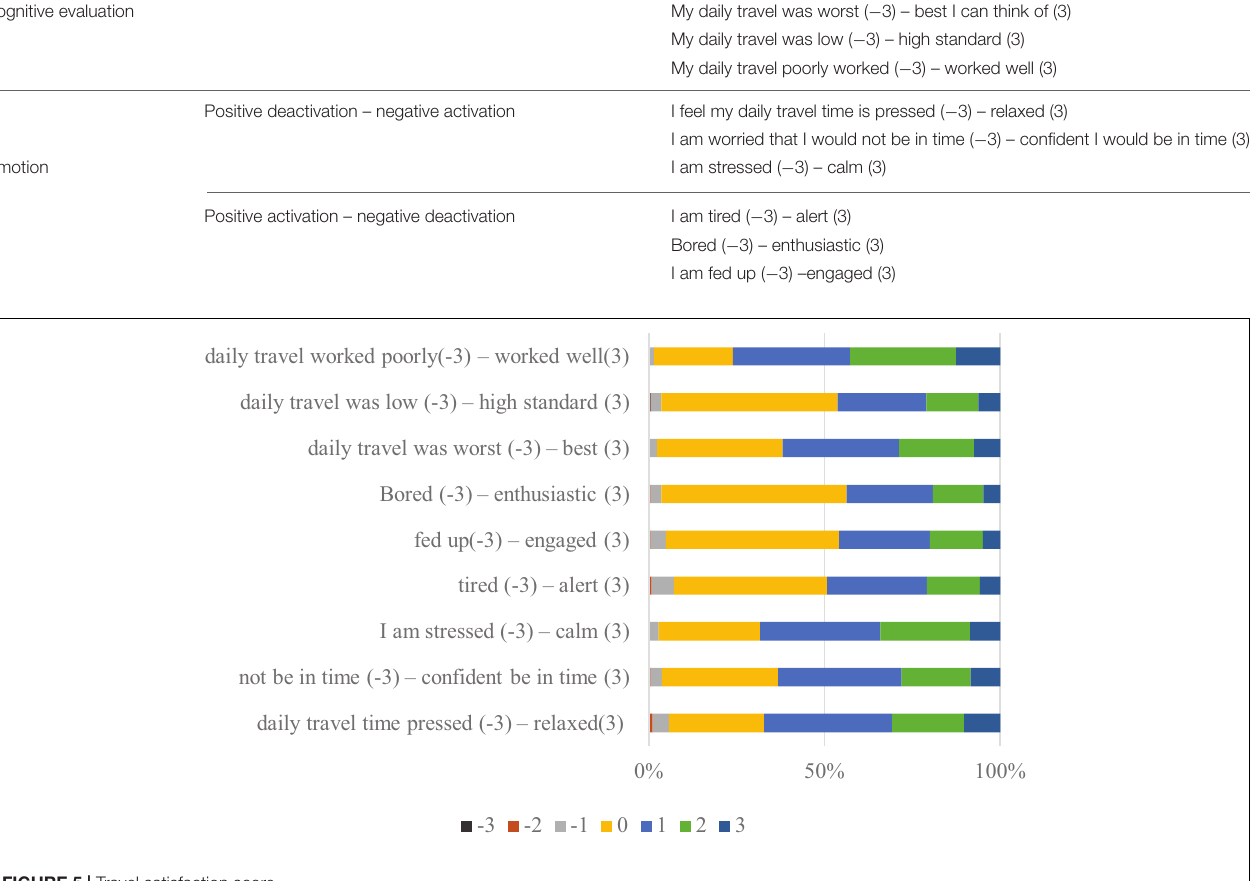
TABLE 2 | Scale of satisfaction (STS).